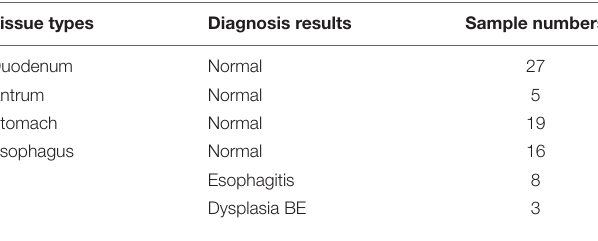
TABLE 3 | Diagnosis results from a pathologist.